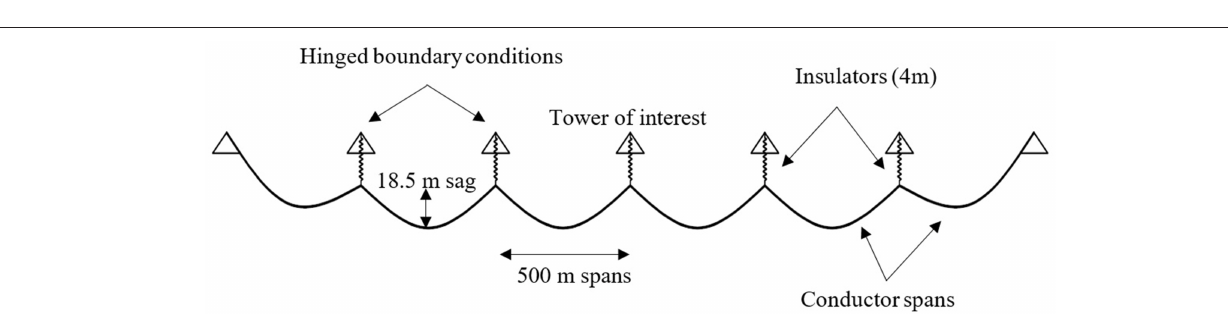
FIGURE 7 | Comparison between target and generated coherencies for circumferential direction.